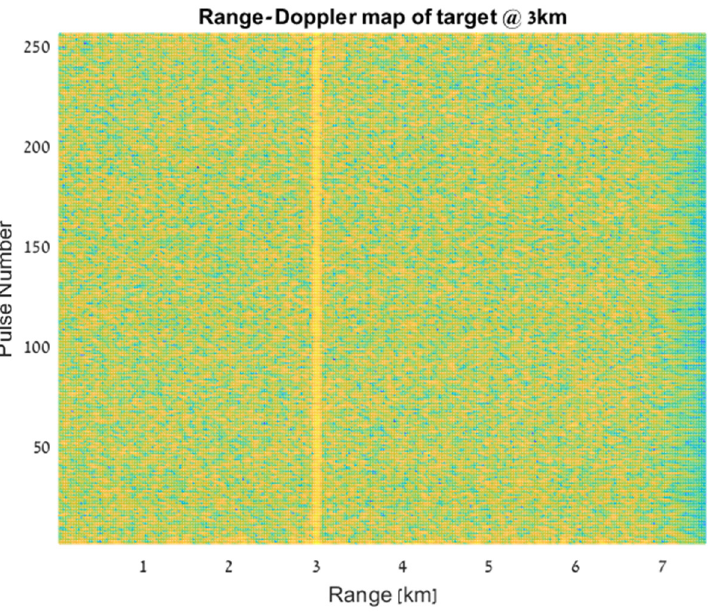
Figure 4. Range-pulse map after matched filter processing in the fast